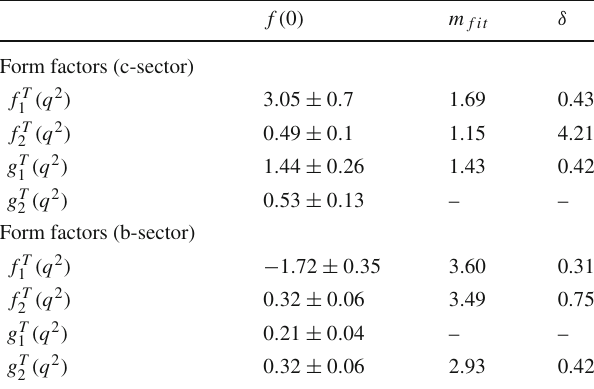
Table 2 The values of the fit parameters for the form factors of the (cid:2) → (cid:3) QQ Q transition